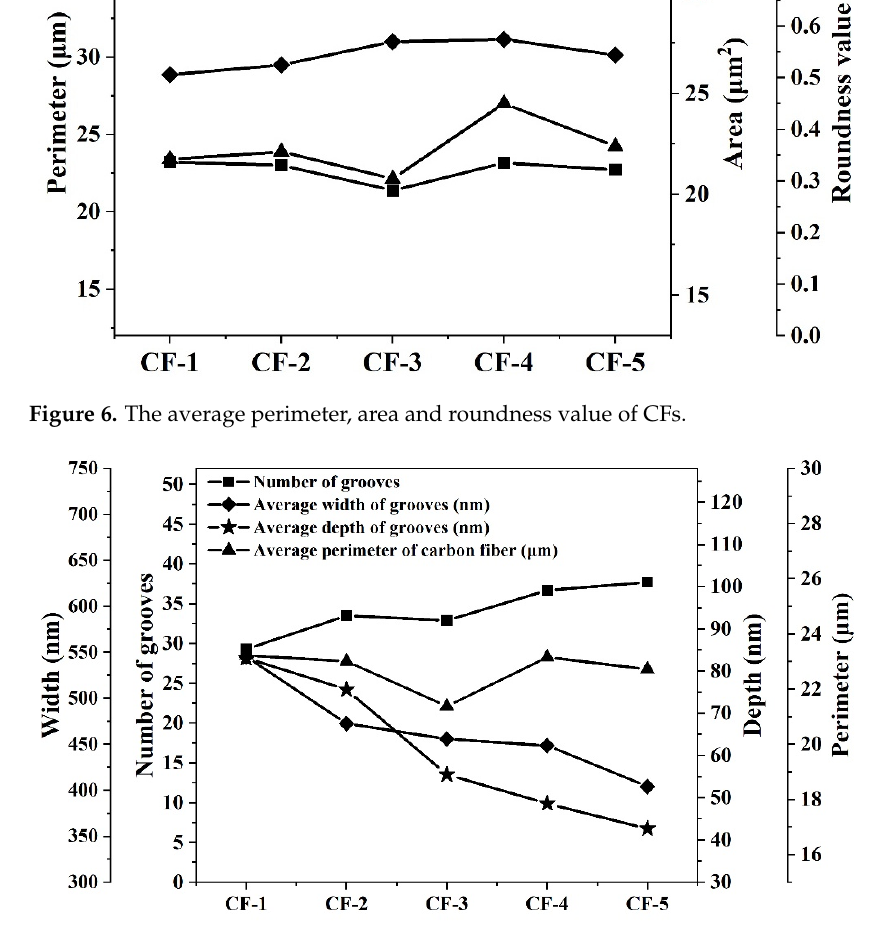
Figure 7. The relationship between groove parameters and average perimeter of CFs.